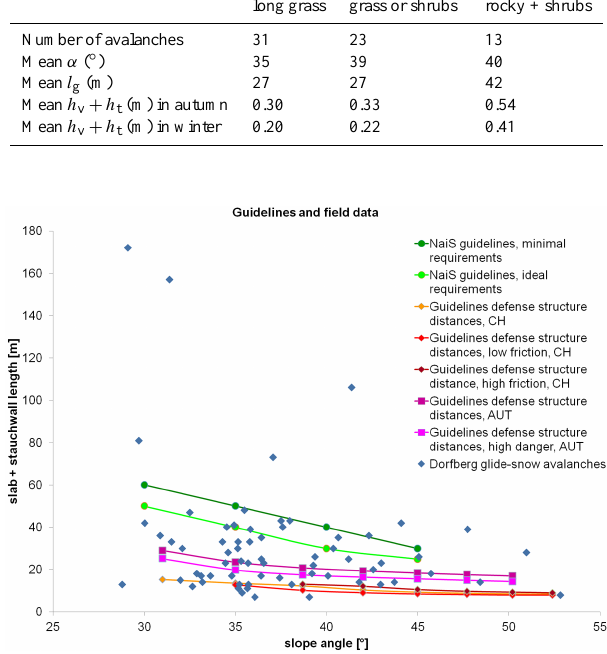
Figure 11. Comparison of guidelines with Dorfberg data. Note that most of the Dorfberg glide-snow avalanches had longer slab lengths and released on steeper slopes than proposed by the defense struc- ture guidelines of Switzerland. In contrast, forest gaps with slope angles and lengths in accordance with the Swiss guidelines on sus- tainable management of protective forests (NaiS) would not have hindered avalanche formation in a lot of cases on the Dorfberg.